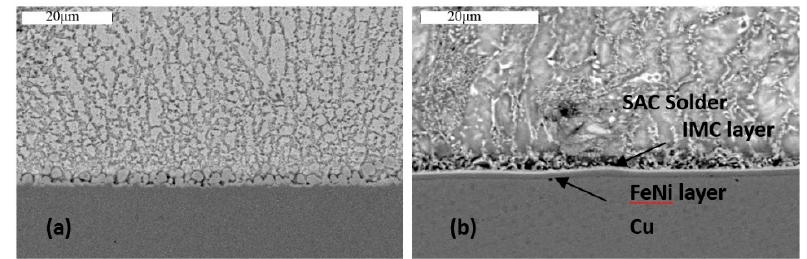
Figure 2. Intermetallic compounds (IMCs) between SnAgCu (SAC) solder and substrates after reflowing for 90 s: ( a ) Cu and ( b ) FeNi-Cu.